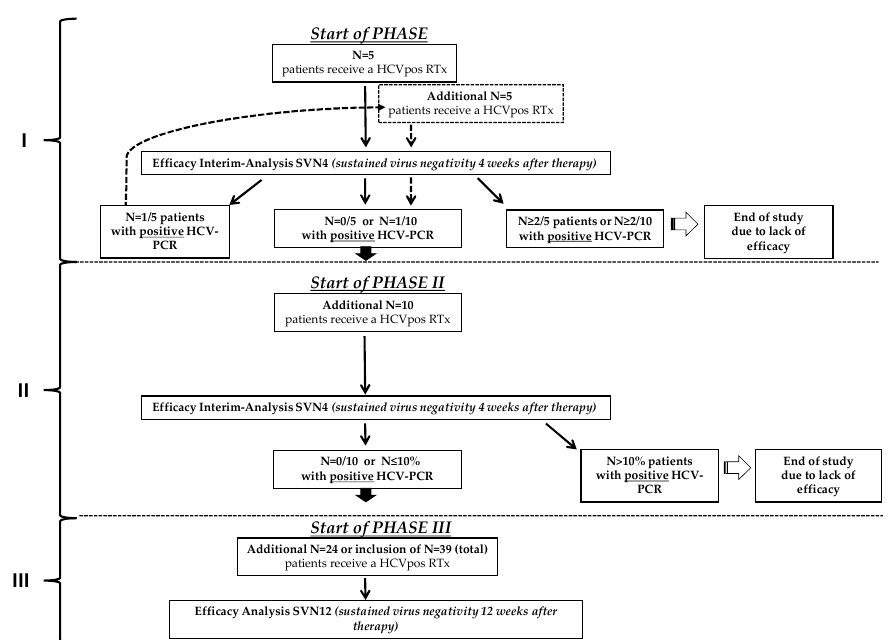
Figure 2: Process of informed consent. Eligible waiting list candidates were approached and educated (individually or in group sessions) on the potential risks and benefits of accepting a hepatitis C seropositive (HCV+) donor organ, the worst-case-scenario and rescue treatment options in case of resistant or refractory HCV virus infection.